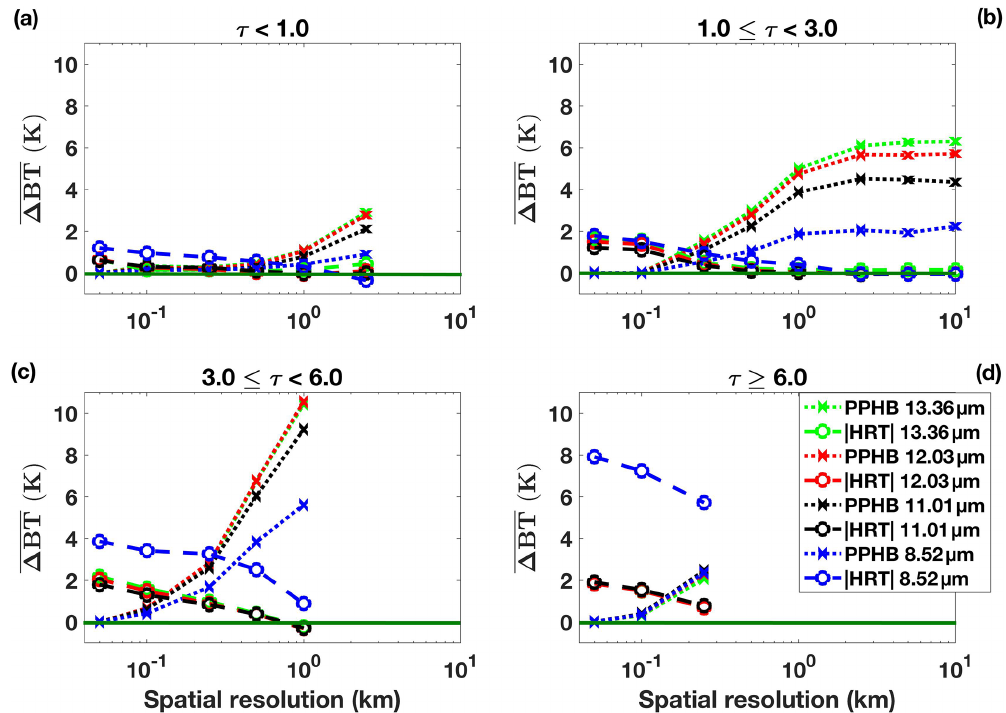
Figure 9. Scene-average, plane-parallel and homogeneous bias (PPHB) and mean deviation due to the horizontal radiative transport ( | HRT | ) effect on brightness temperatures ( (cid:49) BT) for (a) small, (b) medium, (c) large and (d) very large pixel optical thicknesses as a function of spatial resolution in channels centered at 8.52, 11.01, 12.03 and 13 . 36µm. The small optical thickness range corresponds to 28735 pixels, the 17305 medium pixels, the 5028 large pixels and the 1063 very large